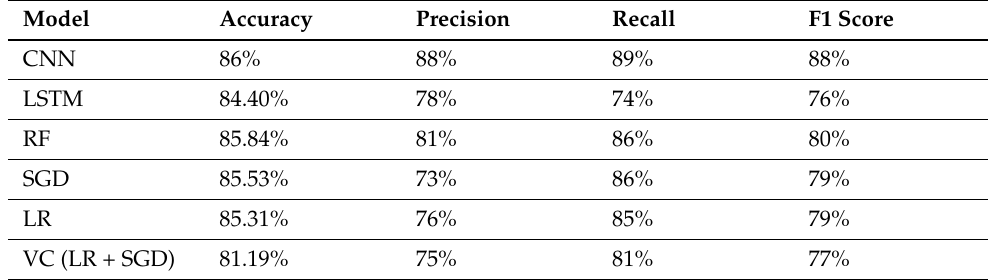
Table 5. Experimental results using the GloVe